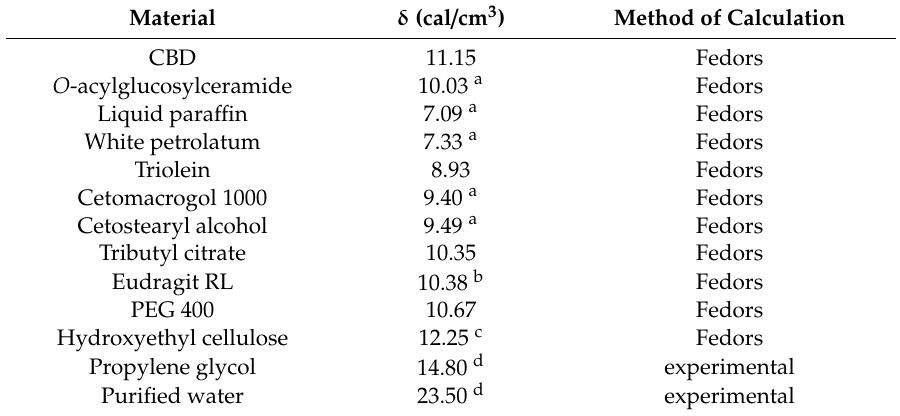
Table 3. Solubility parameters ( δ ) of the components of the solutions and vehicle